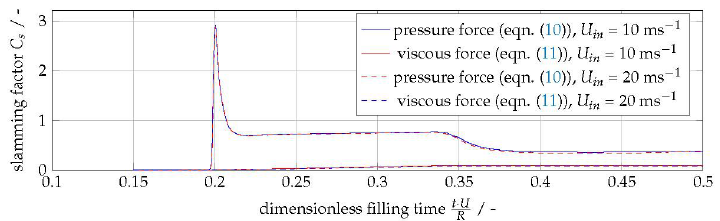
Figure 4. Normalized forces on the core for a mesh resolution of 0.3